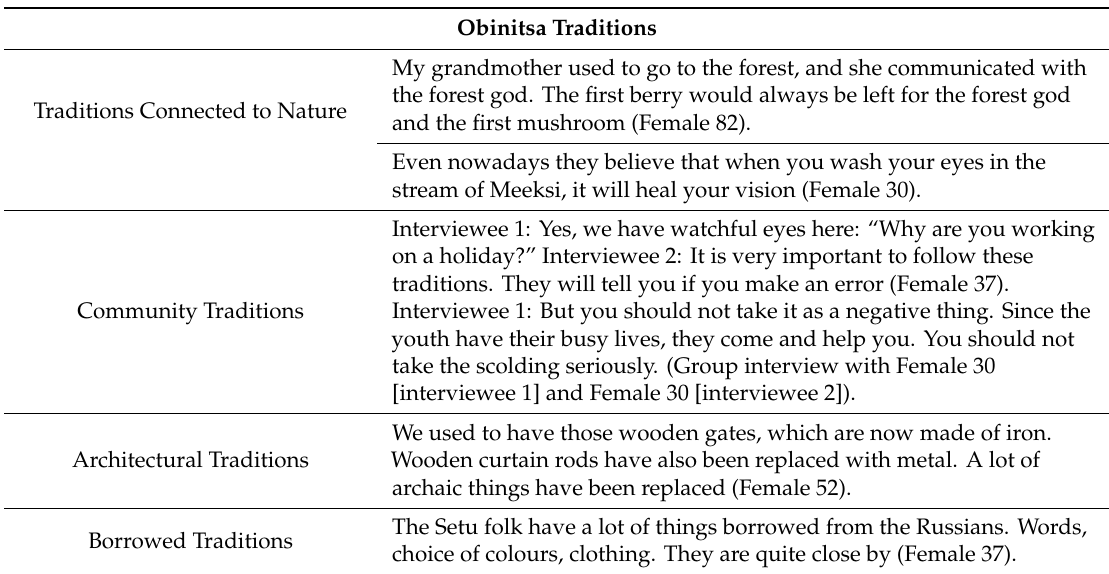
Table 4. Obinitsa